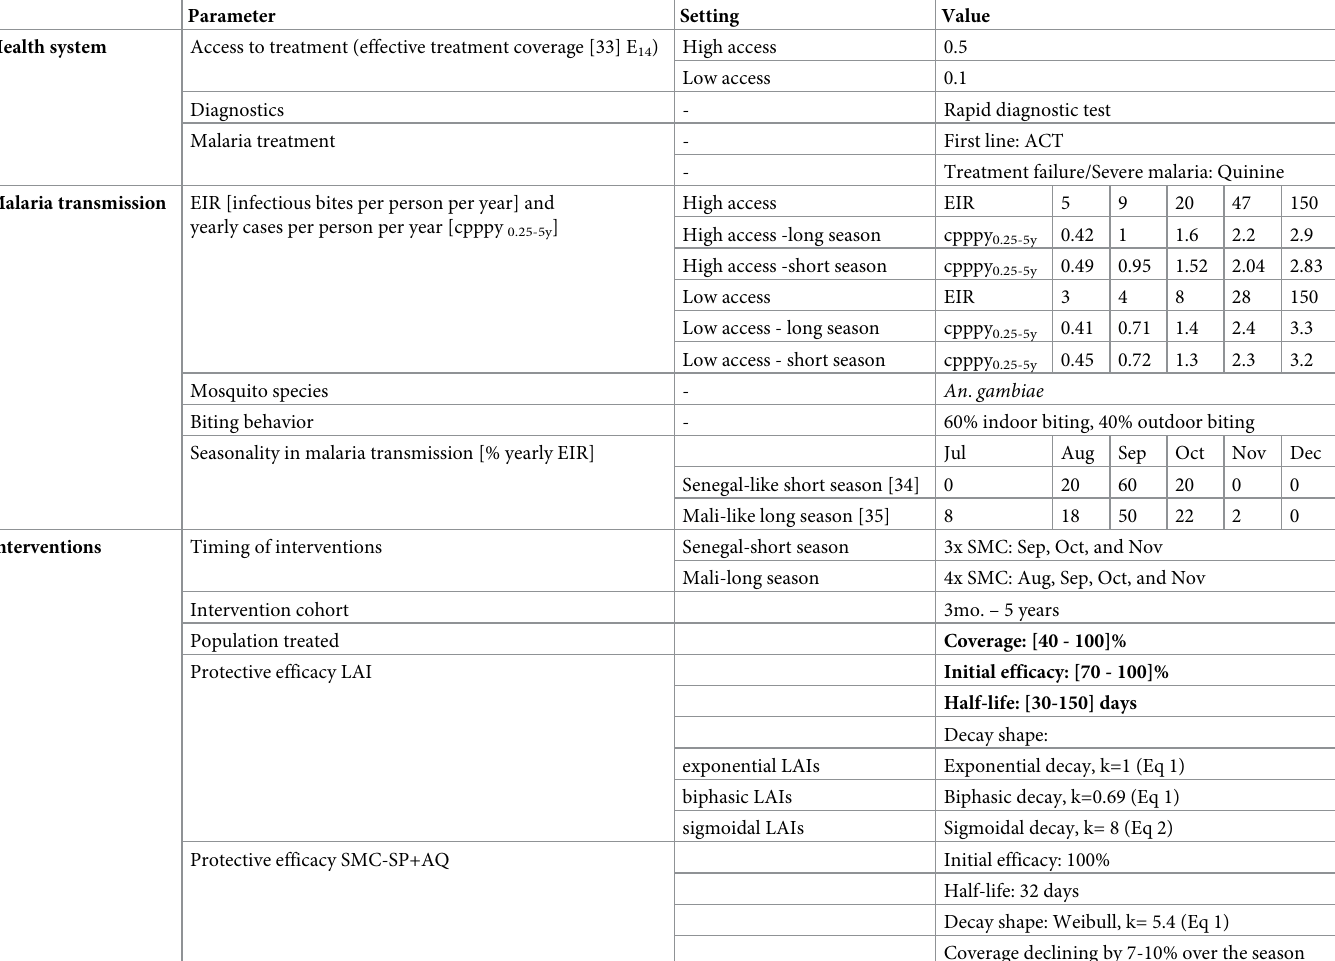
Table 1. Summary of simulation set-up used for the implementation experiments.